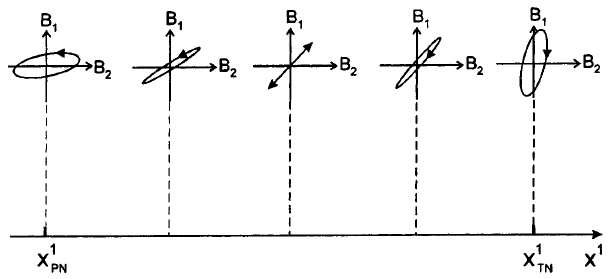
Fig. 1. Hodographs of monochromatic Alfve´ n oscillations with m (cid:29) 1 at di(cid:128)erent points inside the transparency region: between the